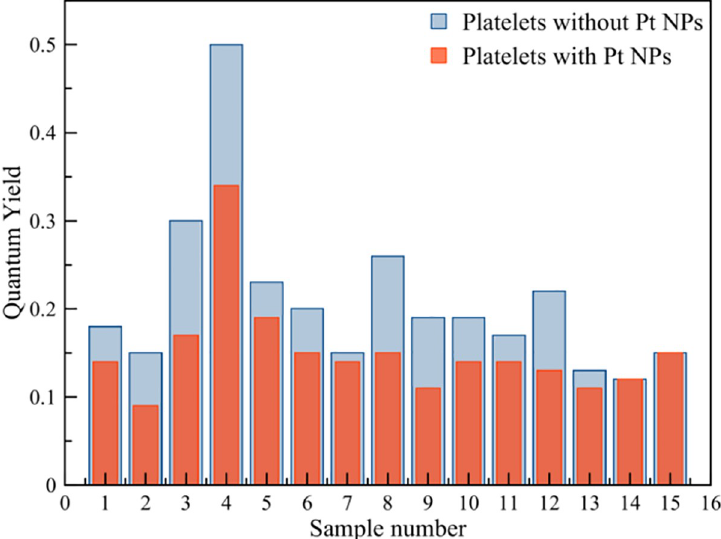
Fig 10. Quantum yield experimental data for platelet samples without Pt NPs (blue columns) and with Pt NPs (red columns).